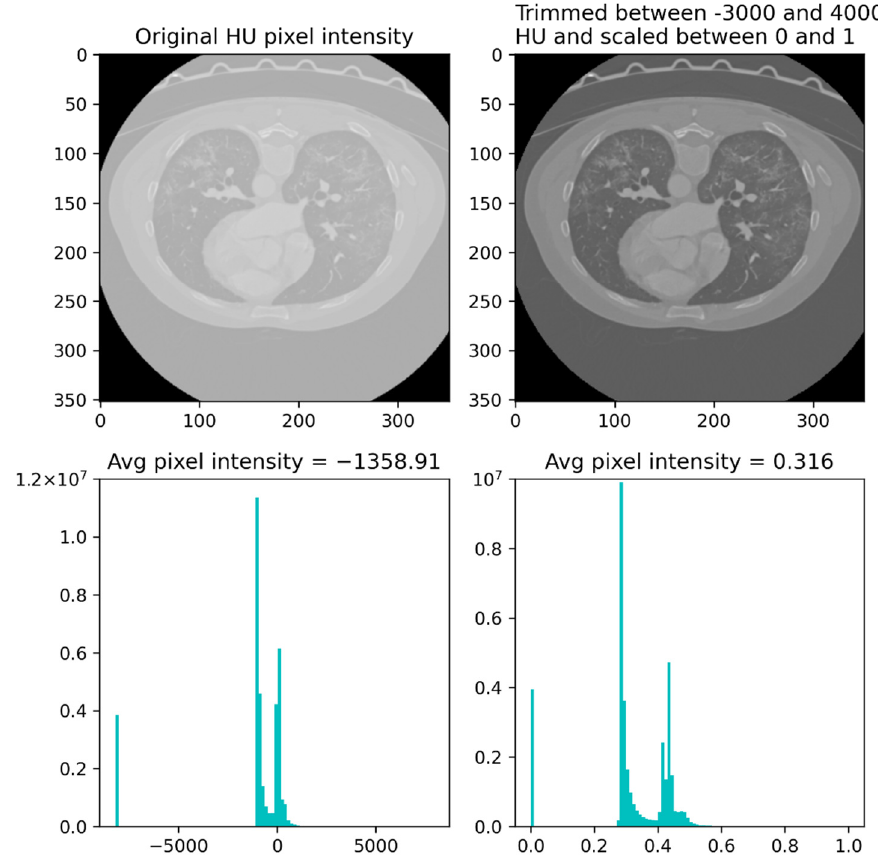
Figure 3. Example of a single slice before and after the pre-processing routine.